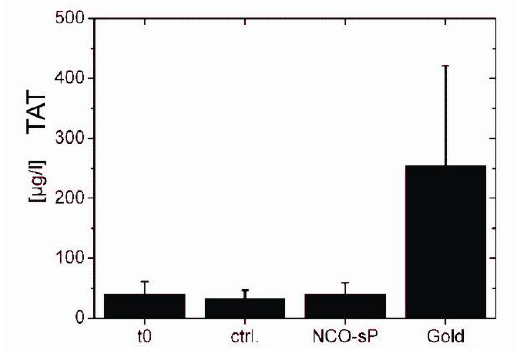
Figure 4. Plasma concentration of coagulation marker thrombin antithrombin complex (TAT). Before (t0) and after 60 min of PRP incubation on the rocking platform. Samples without sensors (ctrl.), with NCO-sP(EO- stat -PO) coated sensors (NCO-sP(EO- stat -PO)) and uncoated gold sensors (Gold). For each group 3 samples (n = 3) were tested.